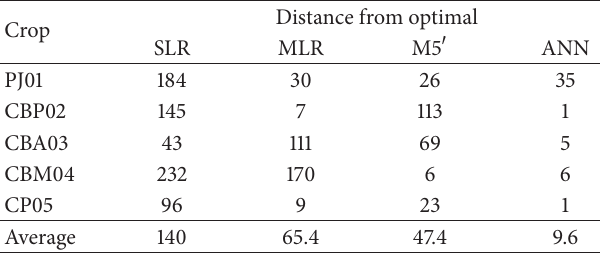
Table 10: Distance from LAS to OAS results. Distance from optimal Crop